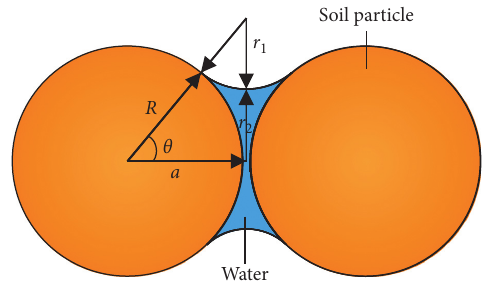
Figure 7: Toroidal geometry of the air-water-solid interface.